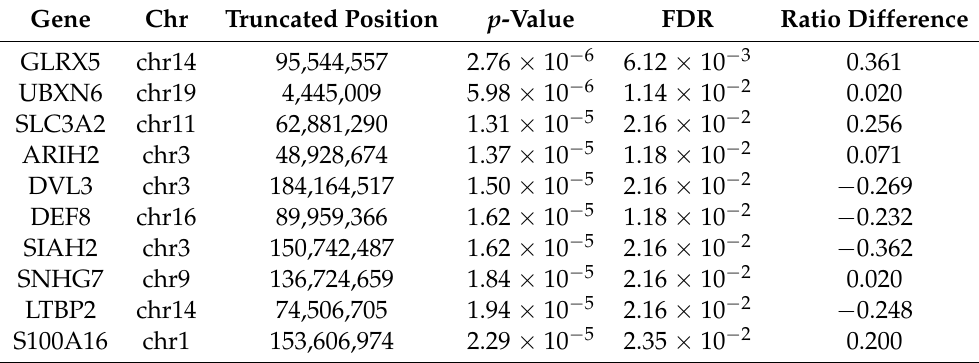
Figure 4. RNA-seq data of mock-treated and SARS-CoV-2 infected A549 cells were analyzed for the CR-APA. The x -axis and y -axis represent the CR-truncation ratios ((short mRNA)/(total mRNA)) of a gene. Each dot represents a gene, where the blue dots and red dots show the significant ones in mock and SARS-CoV-2 infected cells, respectively. Upon SARS-CoV-2 infection, 656 genes showed up-regulated CR-APA while 1206 genes showed down-regulated CR-APA. A total of 8832 genes remained unchanged in their CR-APA. Table 5. Top 10 significant alternative polyadenylation events in the coding region (CR-APA) between A549 mock-treated and SARS-CoV-2 infected